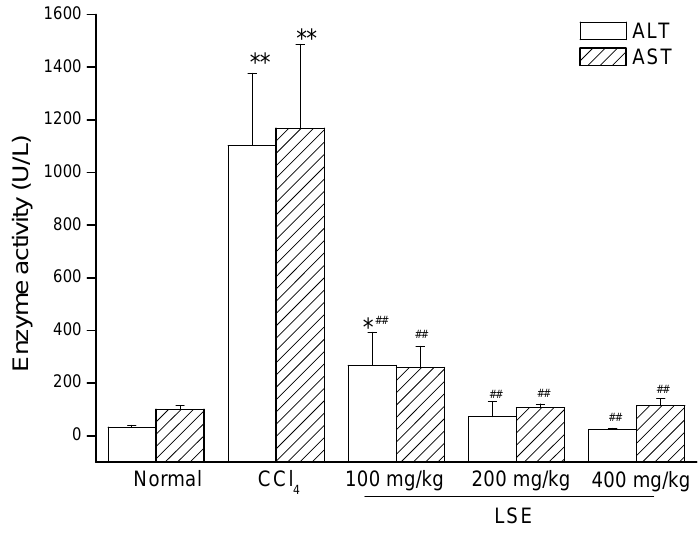
Figure 1. Effect of LSE on the elevation of serum AST and ALT activities in CCl Mice were divided into groups as follows: Normal, CCl mg/kg LSE. CCl and different LSE groups were orally treated with saline or various concentrations of 4 LSE for 5 d prior to the intraperitoneal injection with CCl later. Each value represents mean ± S.D. of 8 mice. *P<0.05, **P<0.01 vs. Normal, ## P<0.01, vs. CCl